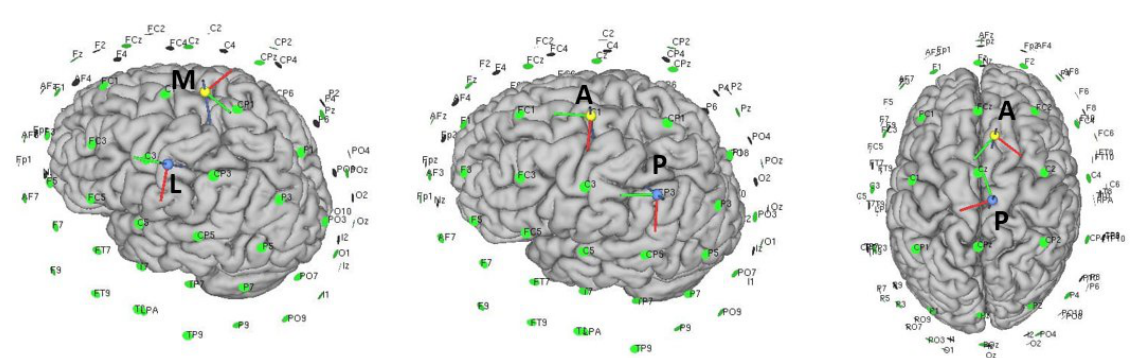
Figure 2. Different types of electrode positionings with respect to the upper-limb area in the first two images and the lower-limb area in the last